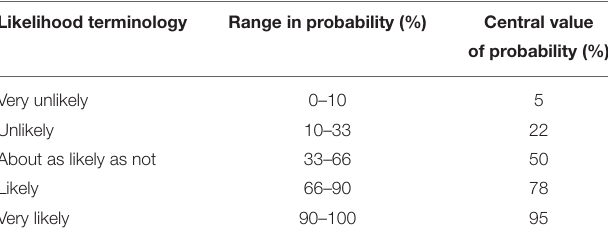
TABLE 3 | Five-fold classification of likelihood adopted for the parameterization of Multihaz (after Le Treut et al., 2007). Likelihood terminology